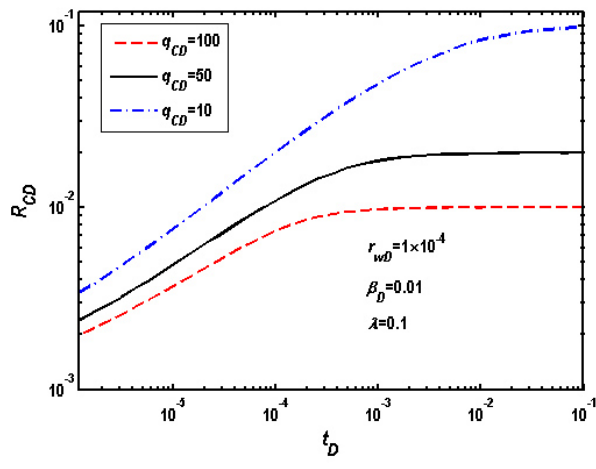
Figure 6. Time-dependent critical radius ( R CD ) for different values of the critical specific discharge.